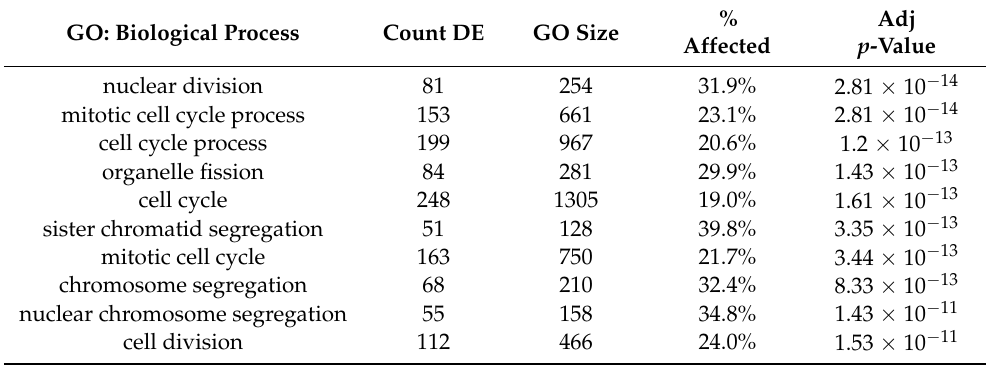
Table 1. Prostate Cell Senescence Top 10 Affected Gene Ontology Biological Process terms. Adjusted p -value (FDR) <